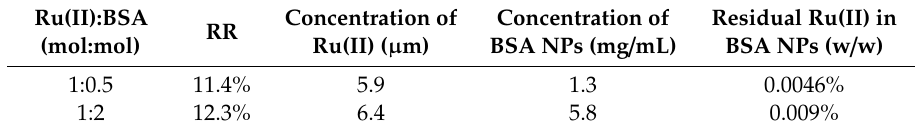
Table 2. The statistics of the residual rate (RR) of Ru(II) and the concentration of Ru(II) in 30 nm BSA NPs at di ff erent mole ratios of initiator to